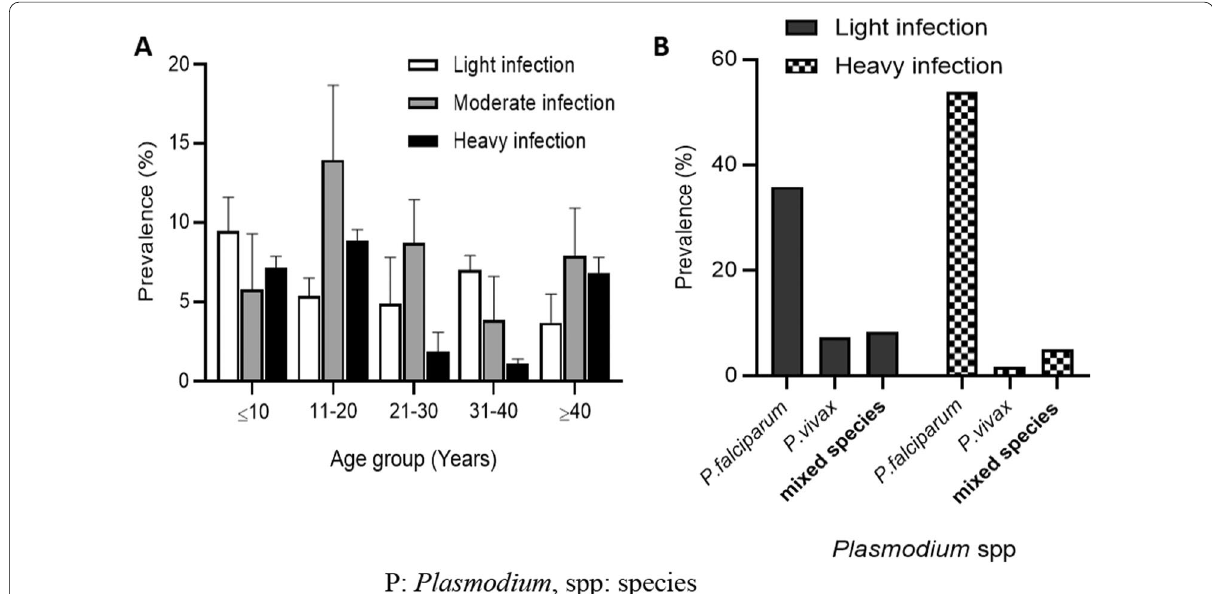
Fig. 2 Malaria intensity stratified with age and malaria